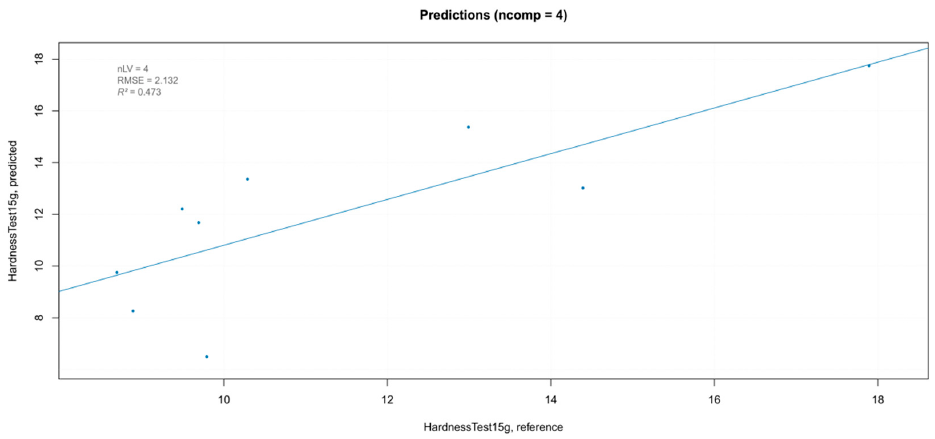
Figure 14. Results of the external validation for the “hardness” parameter.